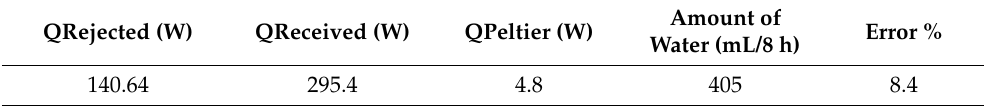
Table 6. Experimentally calculated values of received heat, rejected heat, Peltier heat, amount of water, and error percentage for 8 h of running time (in climate